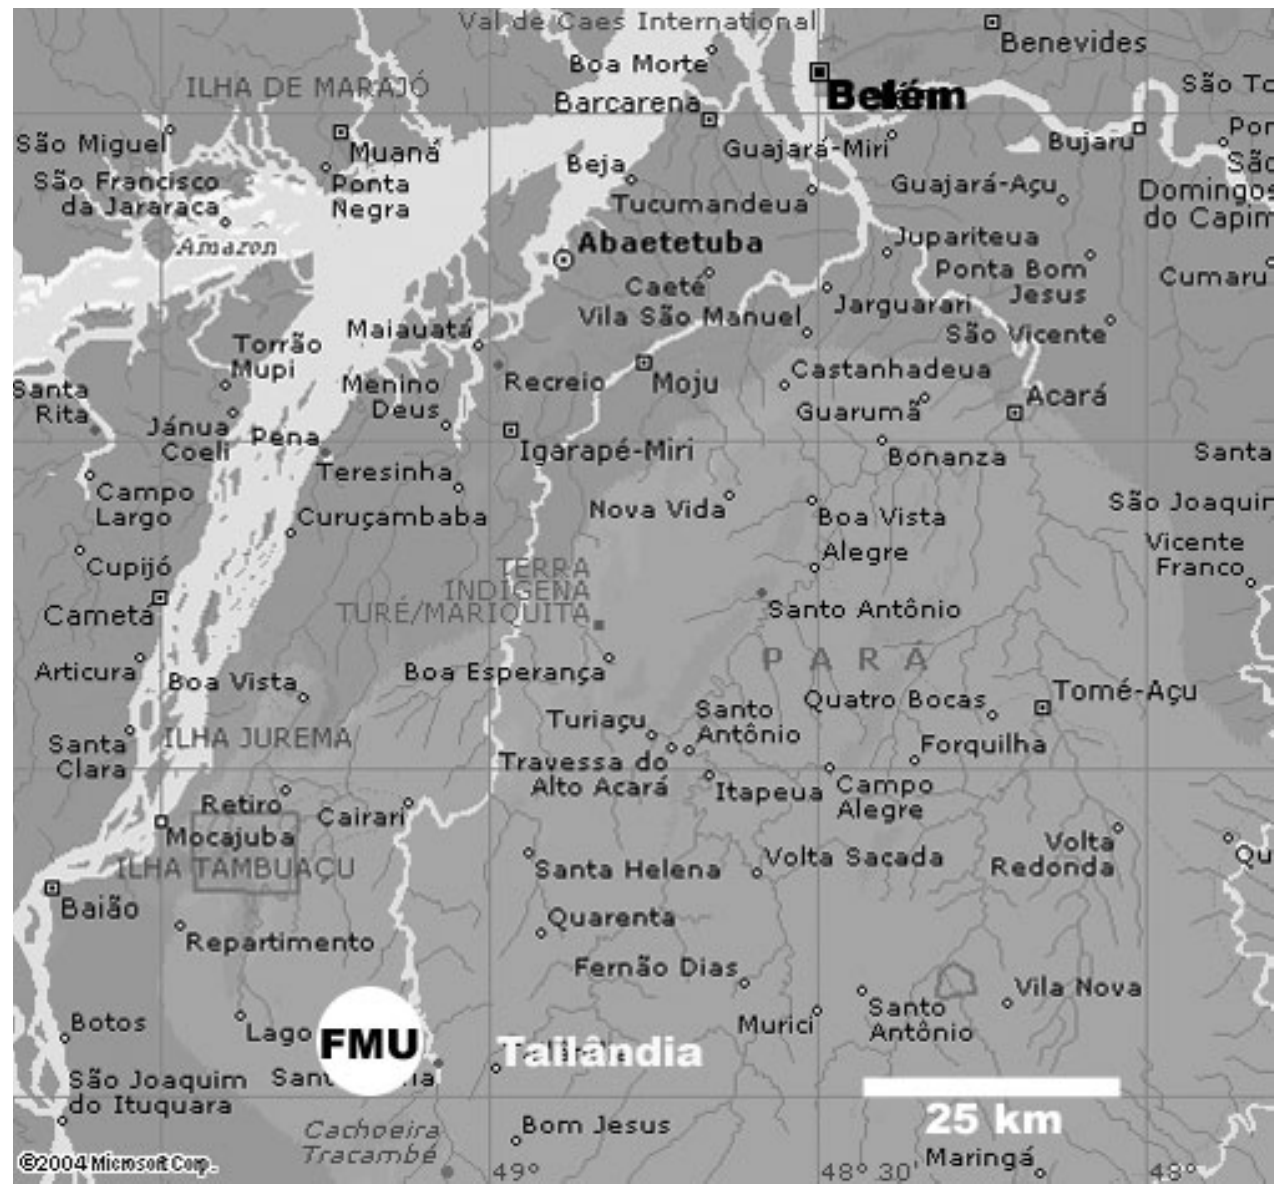
Fig. 2 . The location of the Forest Management Unit “Santa Marta” managed by the Brazilian timber company Juruá Florestal